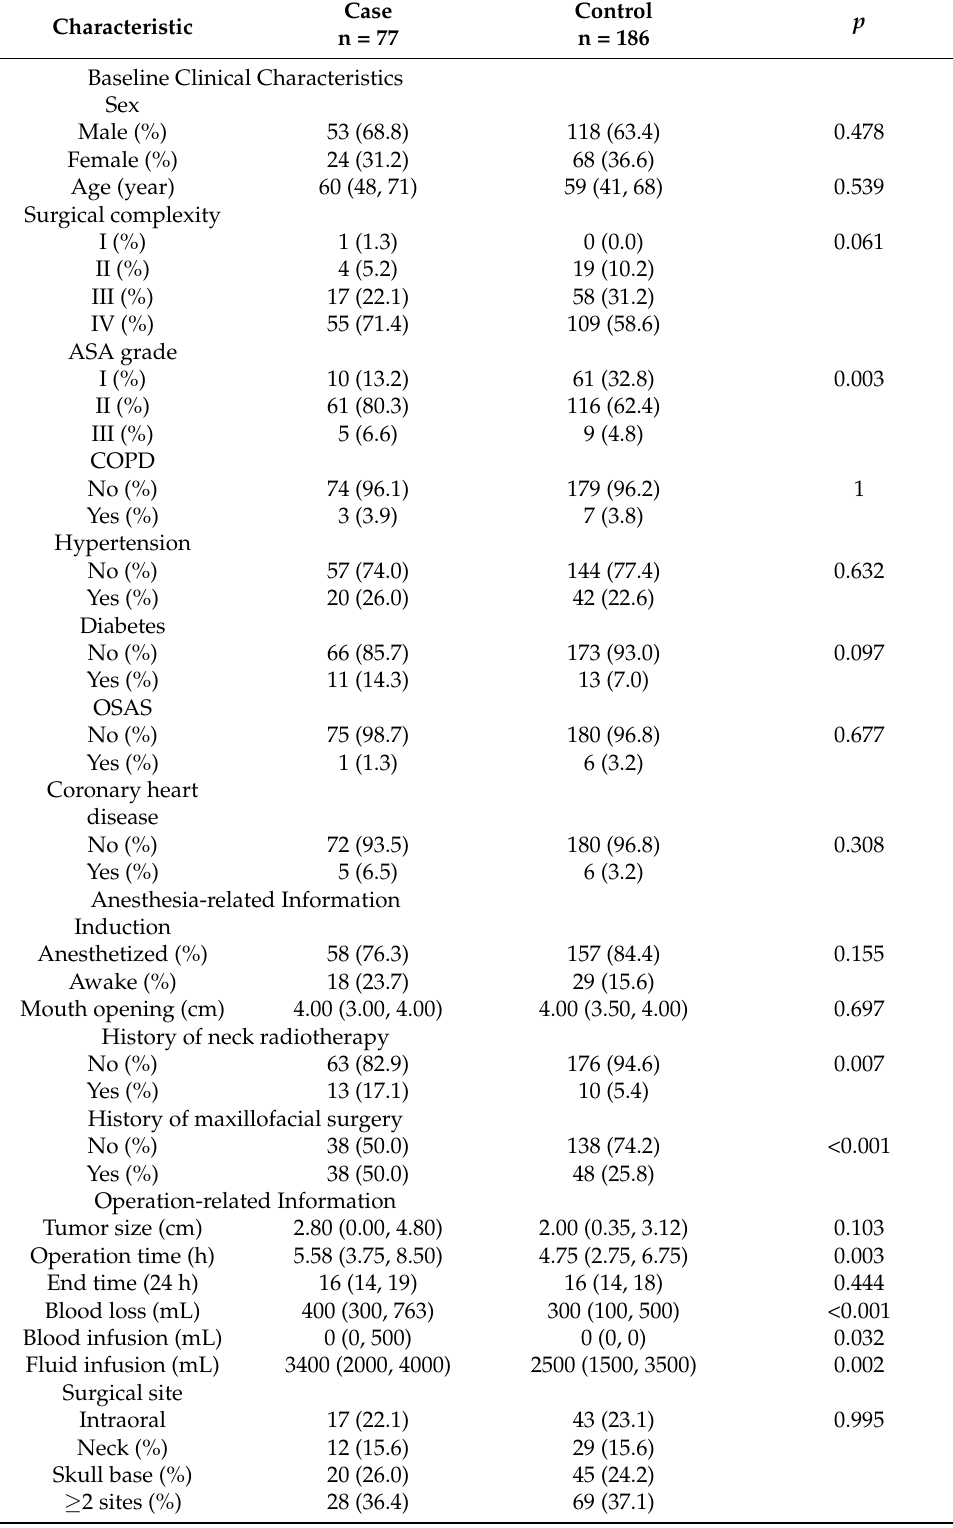
Table 1. Baseline patient clinical features and surgical- and anesthesia-related clinical information applied to the prediction